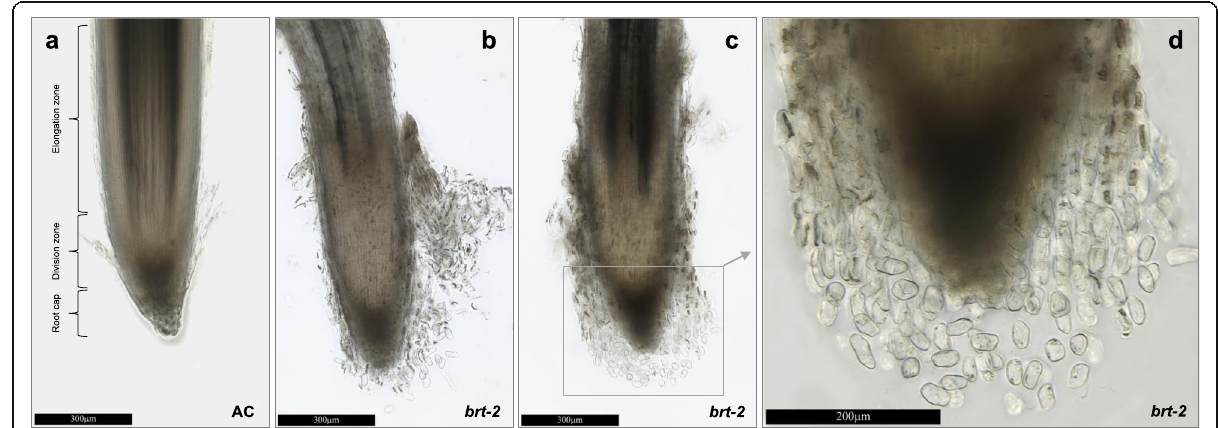
Fig. 5 Composite light microscopy images of AC and brt-2 mutant root tips. Roots from seven-day-old plant of AC ( a ) and brt-2 ( b-d ) were used for imaging, scale bars are